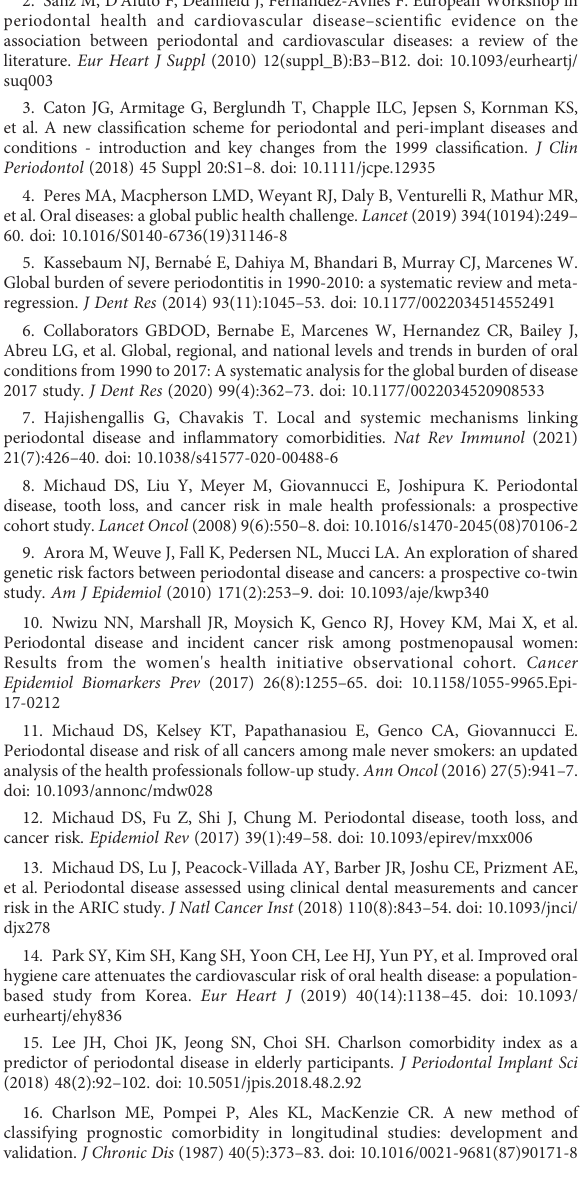
SUPPLEMENTARY FIGURE 1 Cumulative incidence in primary cancer of the stomach, colon, lung, bladder, thyroid, and leukemia in subjects with periodontitis (n=53,075) and without periodontitis